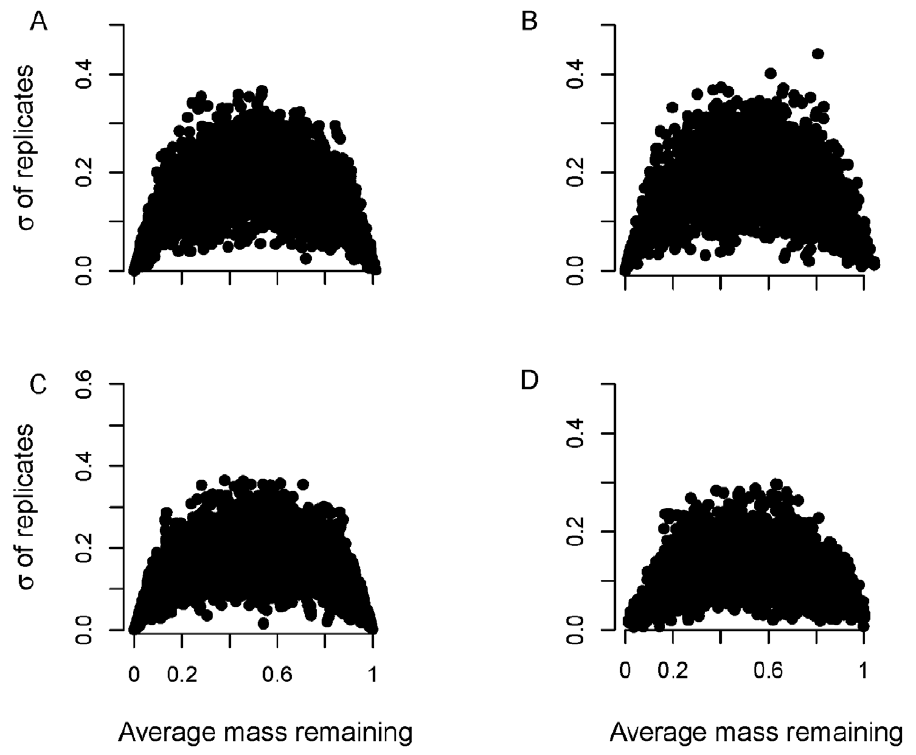
Figure 2. Figure of mean mass remaining versus standard deviation of replicates at each time point for 200 simulations with four different error structures: (A) beta errors + normal errors (option 3a; s =0.0125, w =5); (B) beta errors + normal error (option 3b; s =0.05, w =5); (C) beta errors (option 2; no 0 or . 1 values, w =5); and (D) normal error with variable s (option 1; Var s 2 ).